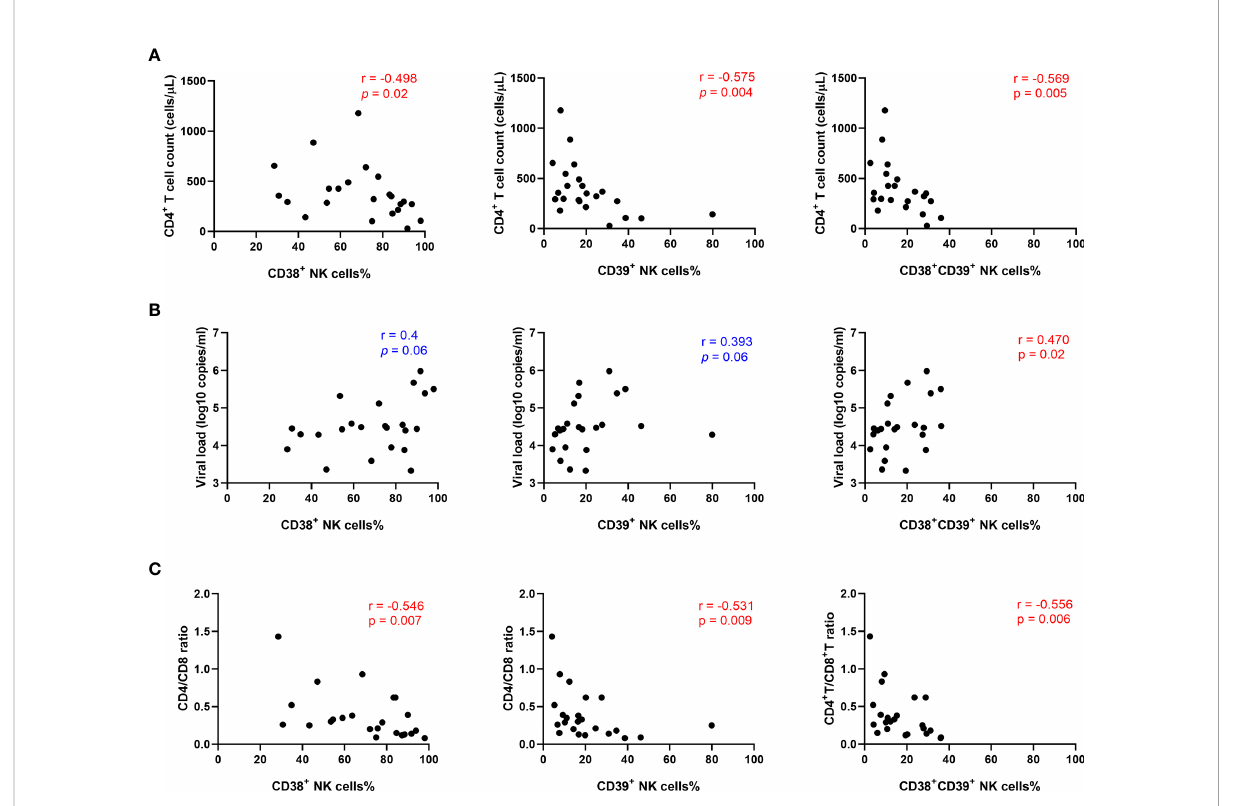
FIGURE 3 The percentage of CD38+CD39+ NK cells was positively associated with HIV disease progression. (A) Association between the CD4 + T cell count and the expression of CD38 + , CD39 + , and CD38 + 39 + NK cells in untreated HIV infection individuals. (B) Correlations between the viral load and the expression of CD38 + , CD39 + , and CD38 + 39 + NK cells in untreated HIV infection individuals. (C) Correlations between the CD4/ CD8 ratio and the expression of CD38 + , CD39 + , and CD38 + 39 + NK cells in untreated HIV infection